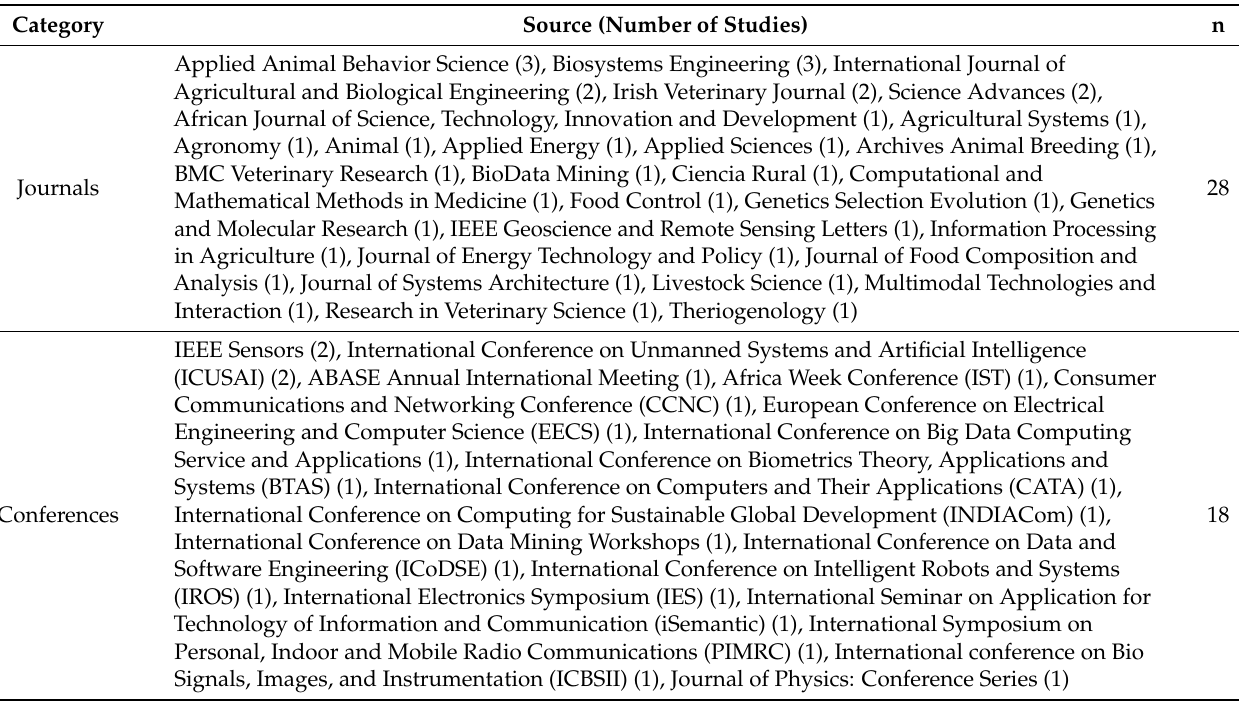
Table A4. List of journals that published less than four studies included in this study and all conference proceedings.